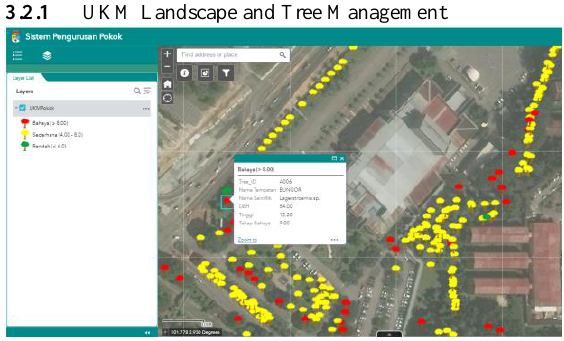
Figure 10. Landscape/tree Management System